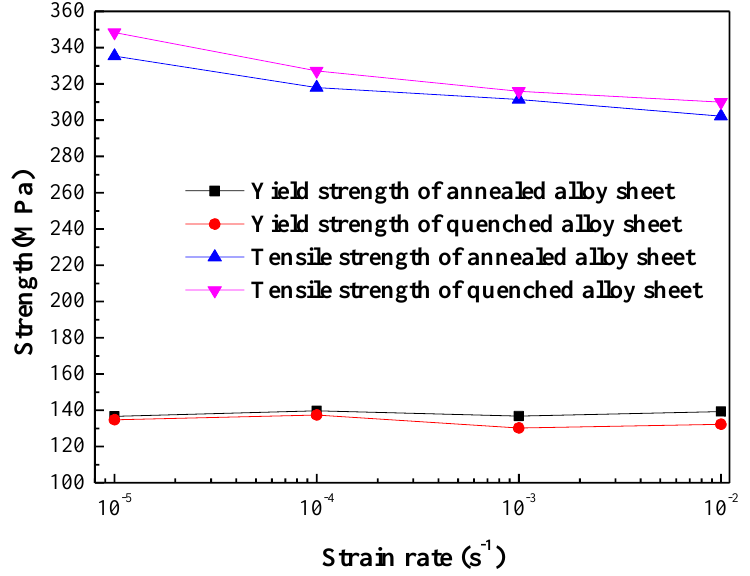
Figure 8. Relationship between strain rate and strength of annealed and quenched 5083 Al alloy sheets.